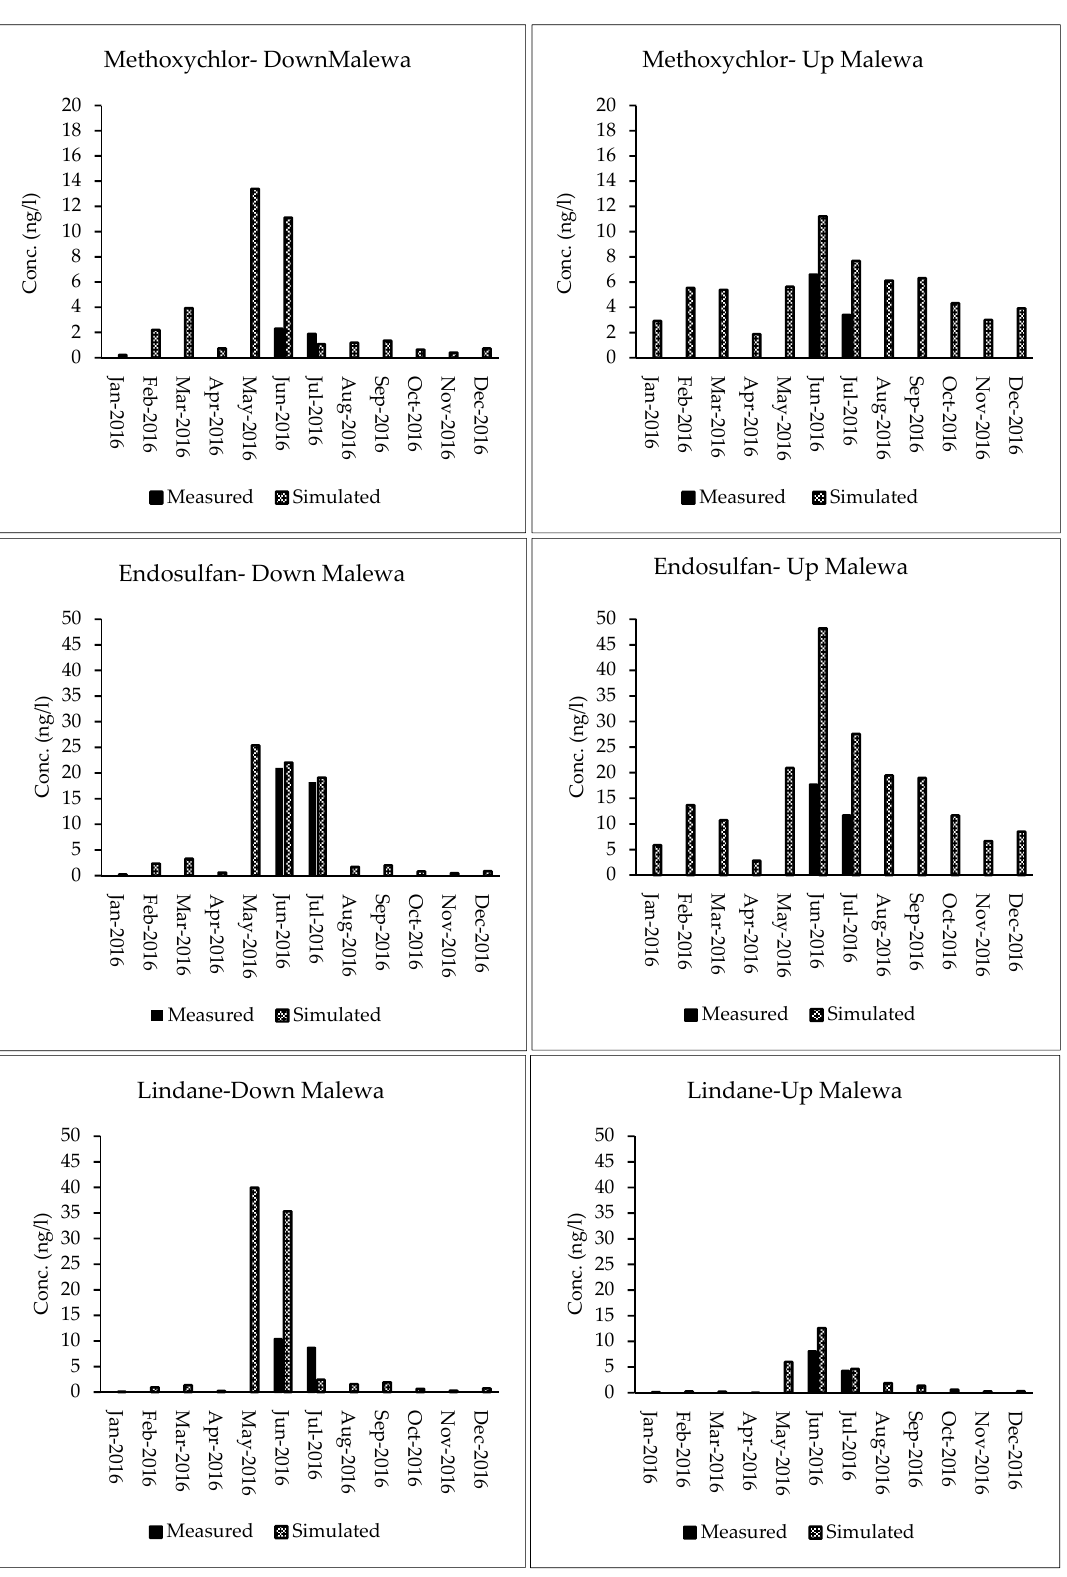
Figure 5 . Comparing Observed and simulated monthly pesticide residue concentrations (Conc.) in the upstream and downstream Malewa River.